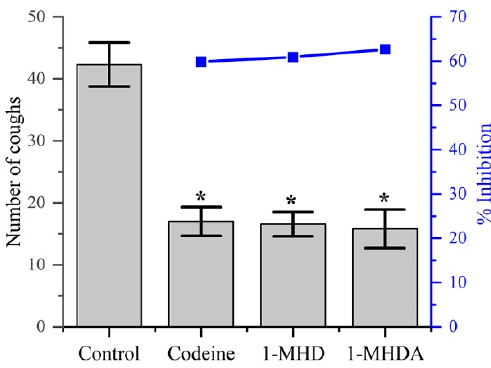
Figure 5. The antitussive plots of number of coughs and the inhibition percentages of different agents. The anti-inflammatory activity was evaluated through xylene induced ear edema in vivo model.